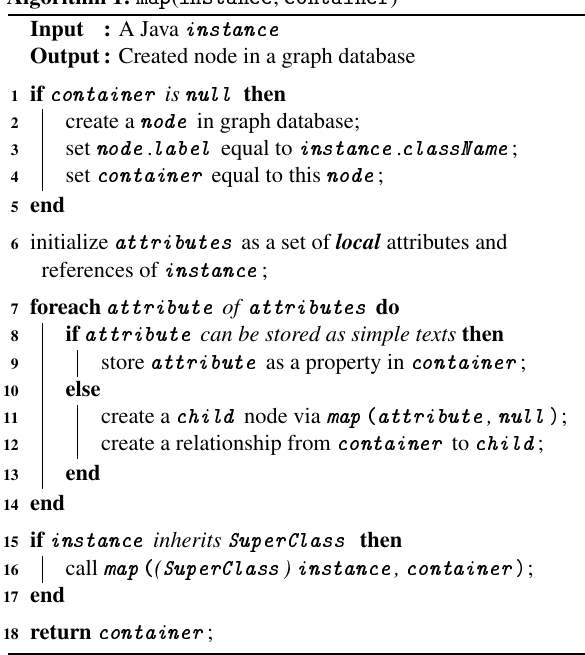
Figure 3. An overview of the mapping